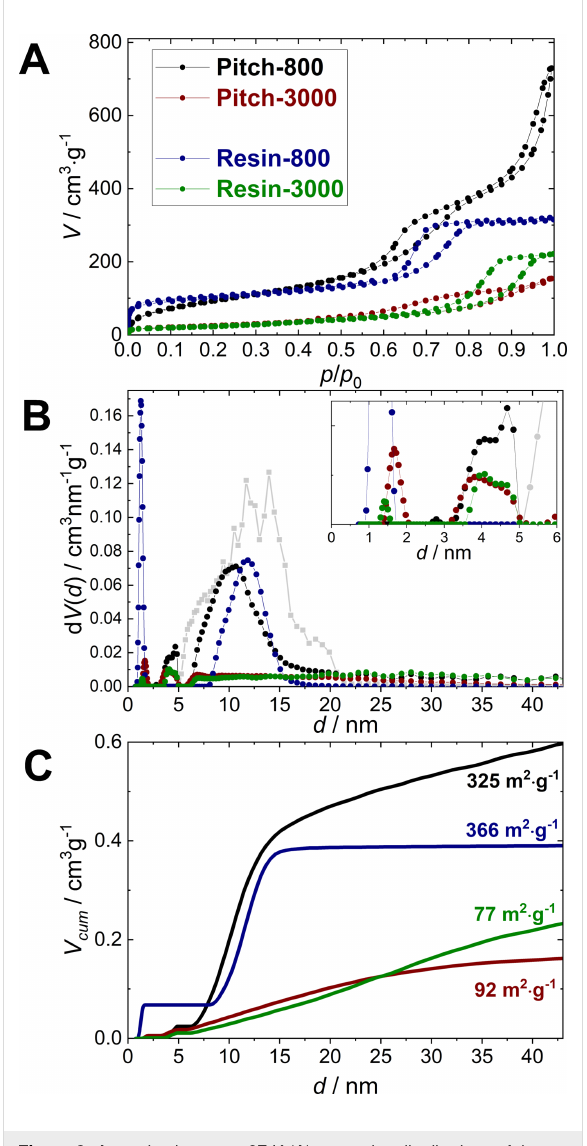
Figure 3: Argon isotherms at 87 K (A), pore-size distributions of the silica template (grey) and the templated carbon materials (B) and cumulative pore volumes